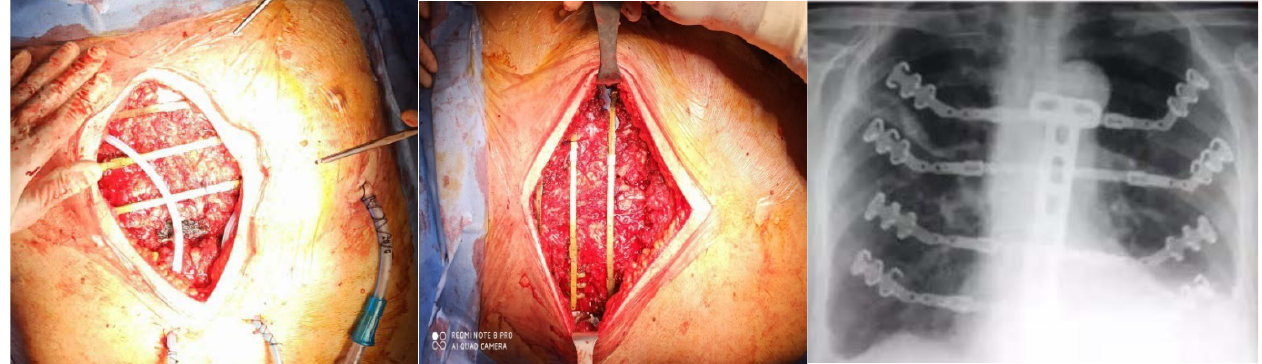
Figure 3. Rib bridge system with titanium-based bars (STRATOS).